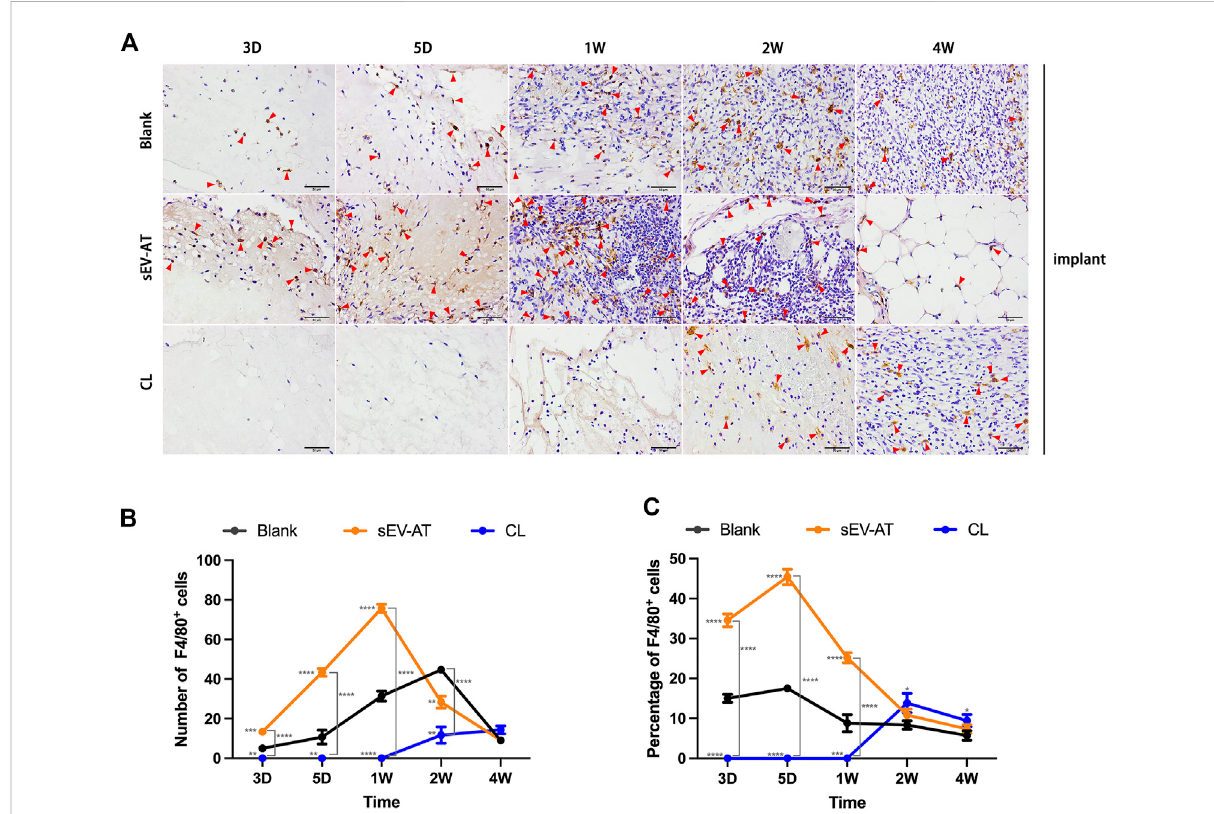
FIGURE 3 In fi ltrated macrophages in theimplants. (A) Representative anti-F4/80 immunohistochemical images of theimplants. The redtrianglespointed out typical F4/80 + cells. Scale bar= 50 µm. (B) The number of F4/80 + macrophages per fi eld ofview (scar bar = 50 μ m) wasanalyzed (n= 3). (C) The percentageof F4/80 + macrophagesin total cells per fi eld of view (scale bar = 50 µm) was analyzed (n = 3). The signi fi cance was tested with ordinary one-way ANOVA followed by Tukey ’ s multiple comparisons test. ( **/***/**** marked beside the data point represented the comparison between the sEV-AT group/the CL group and the blank group, **p < 0.01, ***p < 0.001, ****p < 0.001